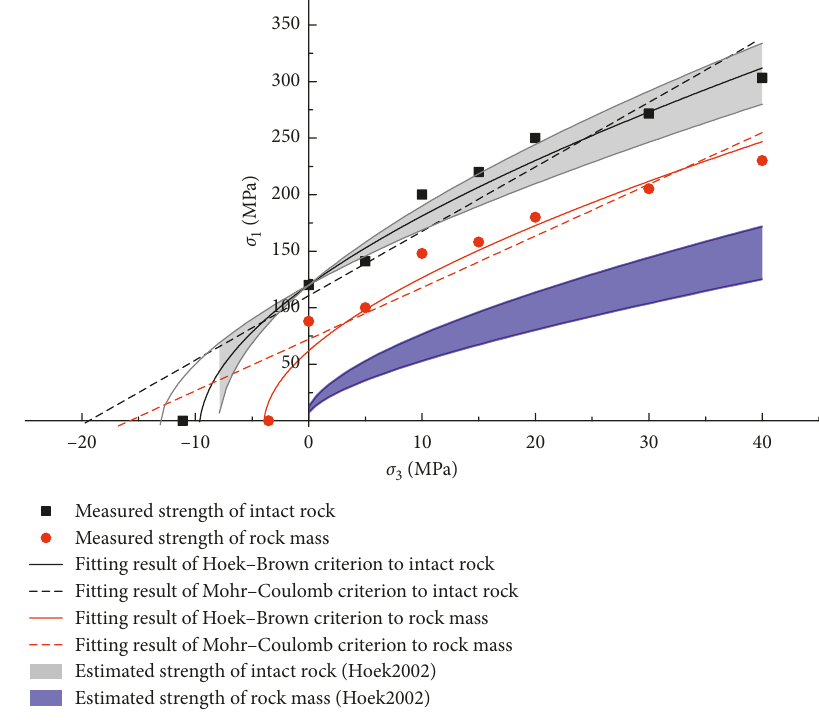
Figure 6: Fitting curves of triaxial tests. Table 1: Basic material properties.